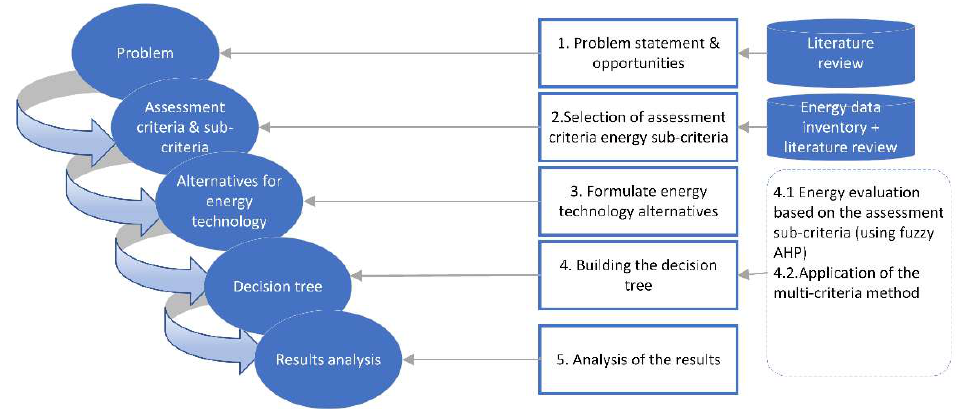
Figure 4. Adopted research methodology for implementation of PT in the implementation of energy-based Industry 4.0 technologies for sustainability.